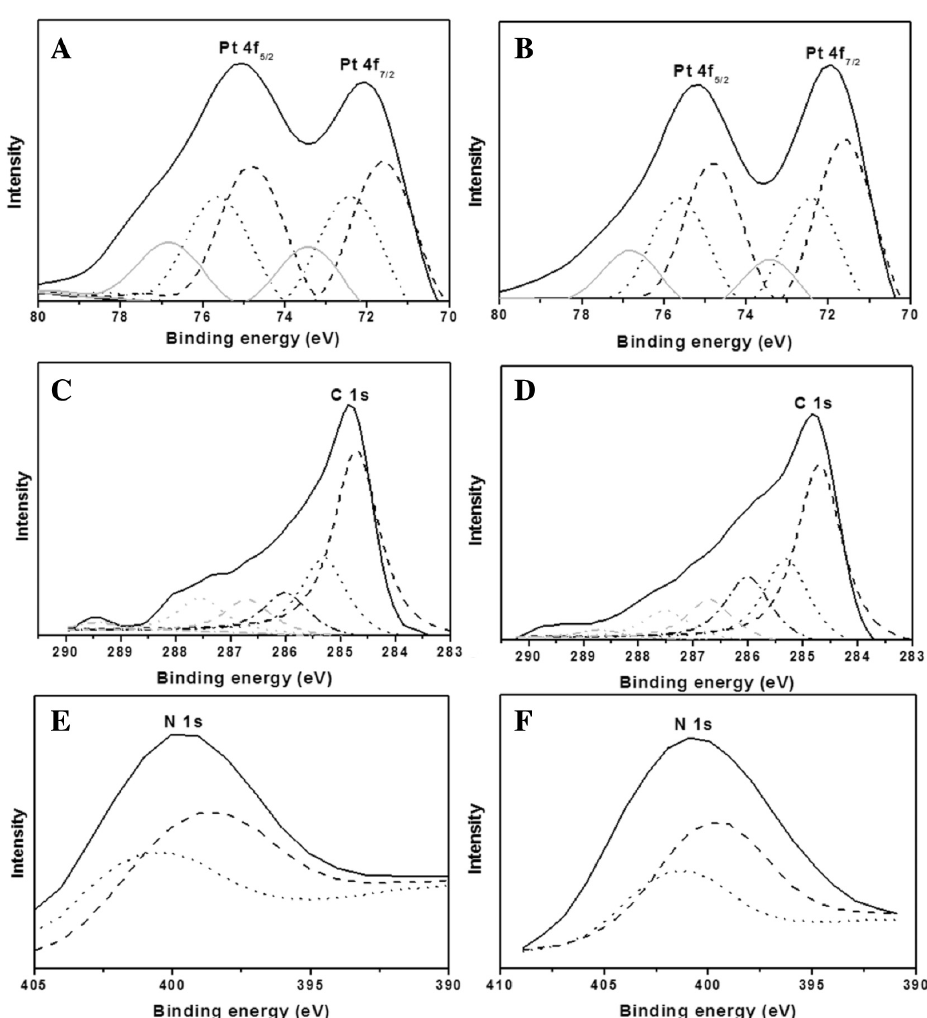
Figure 2. XPS spectra displaying the Pt 4f (A and B), C 1s (C and D), and N 1s (E and F) energy levels of the Pt/[BMIM][PF 6 ]/CNT (A, C, and E) and Pt/[BMIM][Cl]/CNT (B, D, and F)